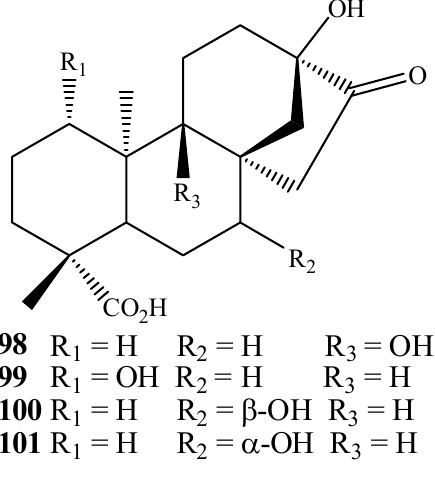
Figure 19. Chemical structures of rearrangements products obtained from biotransformation by C.